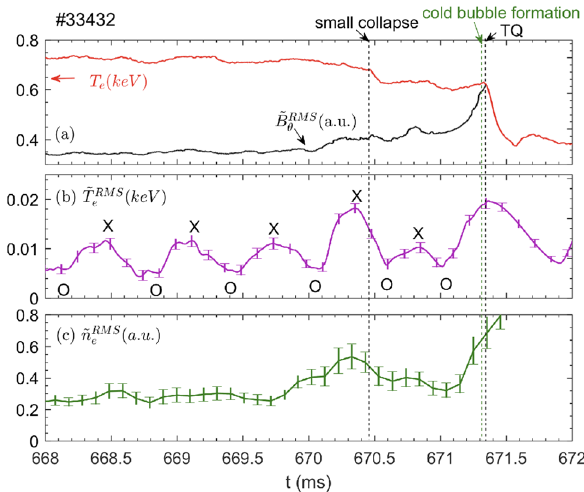
Figure 9. Time evolutions of ( a ) core temperature T e and magnetic fluctuation ˜ B RMS θ in the frequency range of 15–400 kHz, ( b ) temperature fluctuation ˜ T RMS e in the frequency range of 15–100 kHz and ( c ) density fluctuations ˜ n RMS e in the frequency range of 15–400 kHz. The fluctuation data in ( b ) and ( c ) are estimated by averaging several channels around the island X-point. The error bars in ( b ) and ( c ) indicate the standard deviation about the mean obtained in different channels